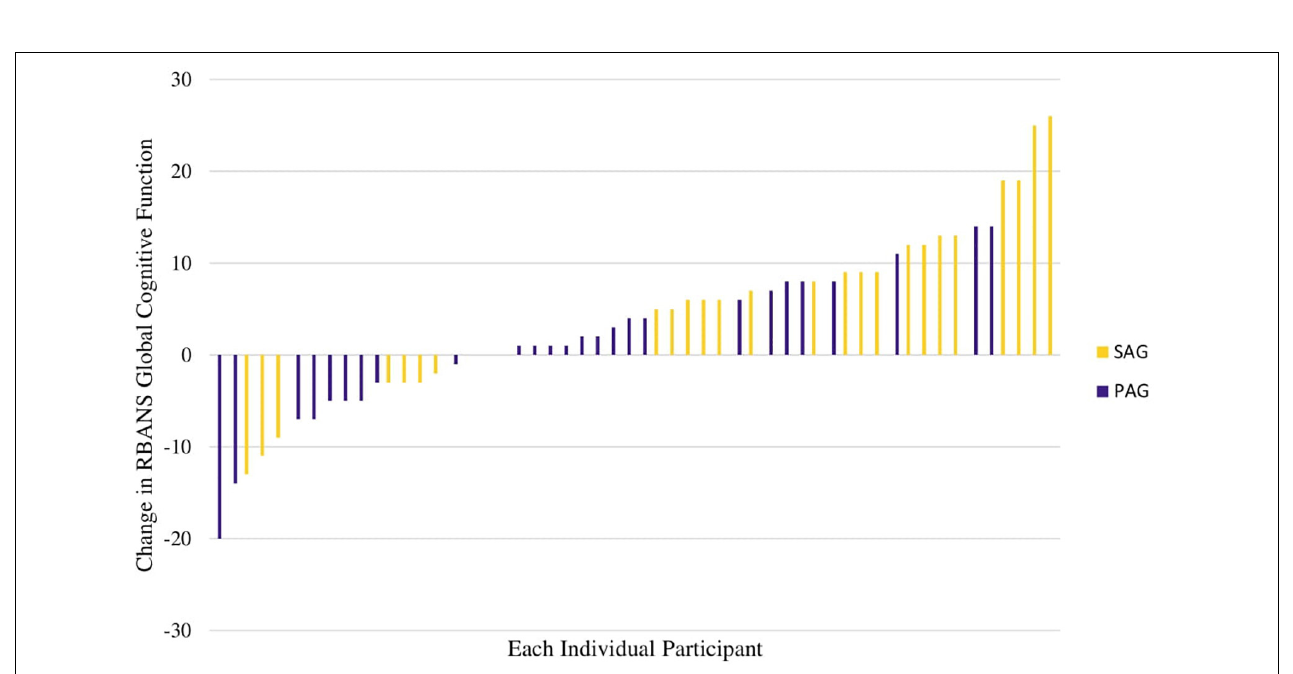
FIGURE 3 | Waterfall plot of individual changes in RBANS total scale change, colored by group assignment (SAG vs. PAG).